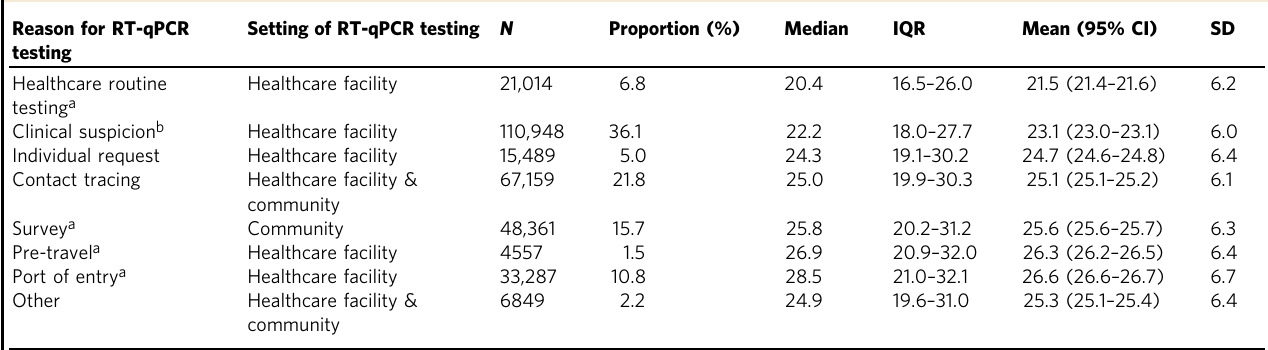
Table 1 Characteristics of RT-qPCR Ct values in the study population. Reason for RT-qPCR testing